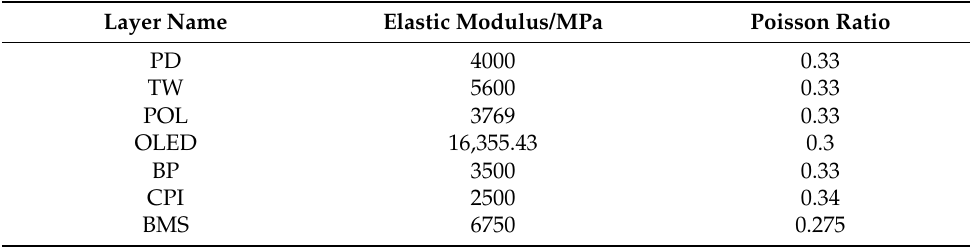
Table 5. Material parameters of each